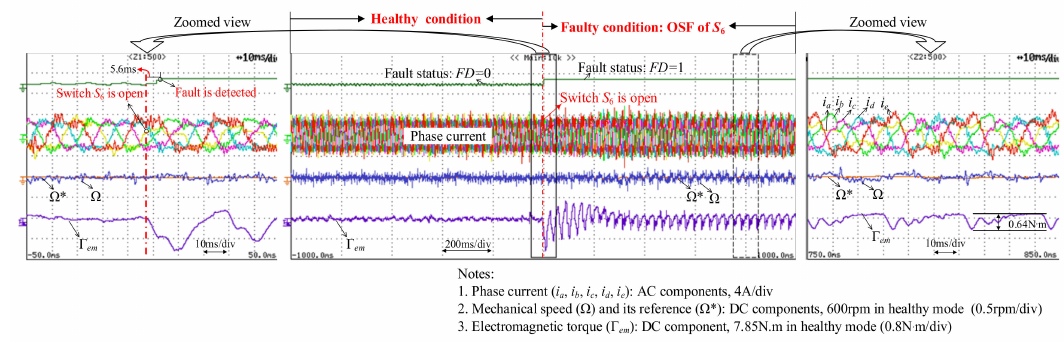
Figure 12. Experimental test with OSF occurrence of S 6 using the proposed AFTC